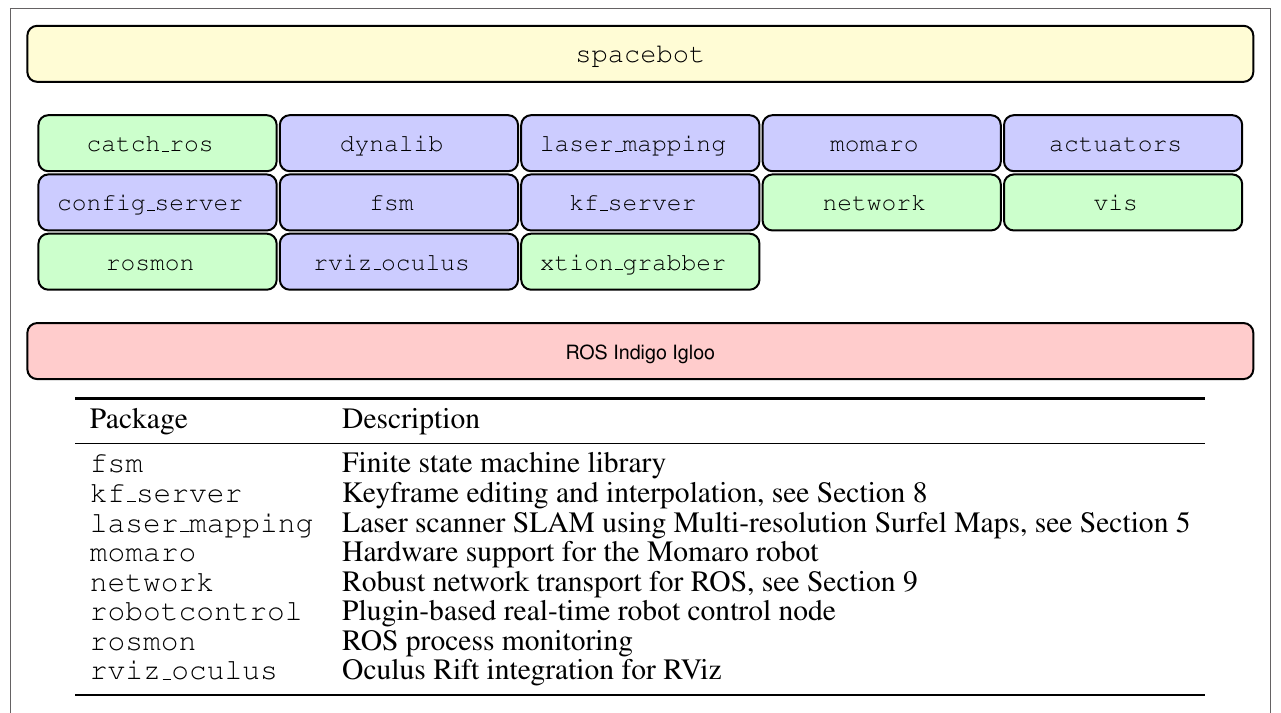
FIGURE 4 | Organization of software modules . At the base, the ROS middleware is used. The blue colored boxes correspond to software modules, shared across robots, projects, and competitions. Finally, the spacebot module contains software, specific to the SpaceBot Camp. Modules colored in green have been released as open source, see